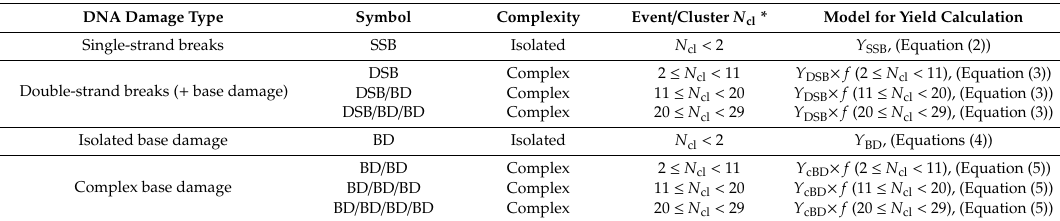
Figure 1. Model validity in comparison with experimental data. ( A ) is the fractions of isolated damage (single-strand break (SSB), base damage (BD)) and complex damage (double-strand break (DSB), complex BD (cBD)); ( B ) is the fractions of simple DSB, DSB / BD and DSB / BD / BD. The experimental data were obtained from the literature with treatment of base excision repair enzymes after 150 kVp X-ray irradiation [37,38] for ( A ) and with the direct observation technique with AFM after 70 kVp X-ray irradiation [41] for ( B ). The calculation represents the present model estimation based on Equations (2)–(5) and cluster analysis based on Table 1, and the determination of isolated or complex damage also follows the summary in Table 1. Table 1. Classification of complex DNA damage coupled with BD in the present model.